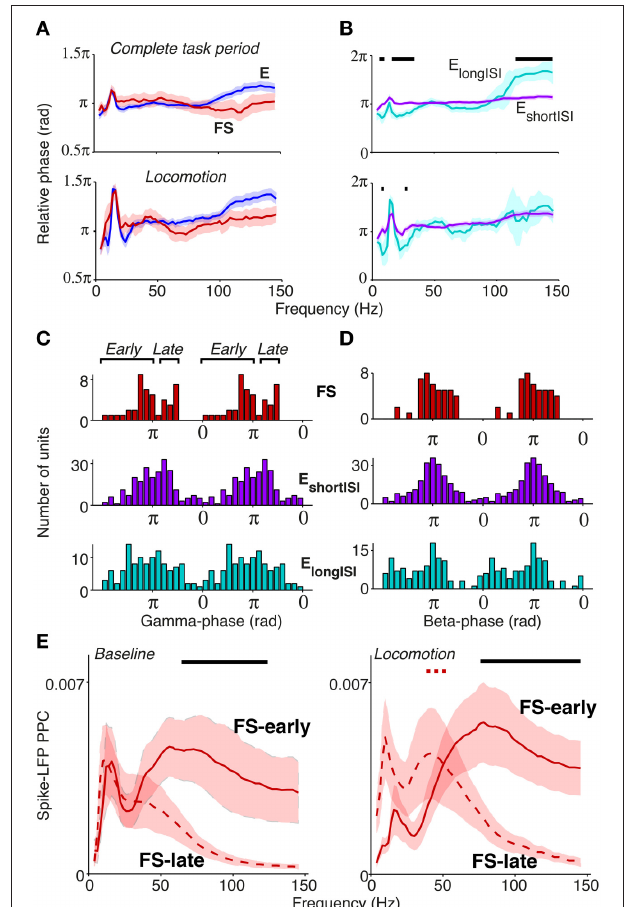
FIGURE 6 | Phase relationships of distinct S1BF cell classes to S1BF LFP. (A) Mean spike-LFP phase for FS and E cells, separately for the complete task period and locomotion. At none of the frequencies did we find a significant difference in preferred phase of firing between FS and E cells. Shadings indicate 72% confidence intervals. (B) Same as (A) , but now for E longISI and E shortISI cells. (A,B) Black, horizontal bars indicate significant mean phase differences between the plotted cell classes (Circular ANOVA, p < 0.05). (C) Histogram of preferred phases of firing in gamma cycle (taken at 66Hz). On average, no significant phase difference between cell classes was detected. FS cells had a significant bimodal distribution of gamma phases (at all frequencies between 42 and 100Hz, p < 0.05, Hartigan’s dip test). (D) Phase histogram at 18Hz for FS, E longISI and E shortISI cells. (E) Mean ± SEM of Spike-LFP PPC spectra for FS cells firing early and late in the gamma cycle, separately for baseline and locomotion. Black horizontal bars indicate significant differences between PPC measures for FS-early and FS-late cells. Dashed red horizontal bar indicates significant difference between baseline and locomotion for late-firing cells ( p < 0.05, multiple comparison corrected for number of frequencies Korn et al.,